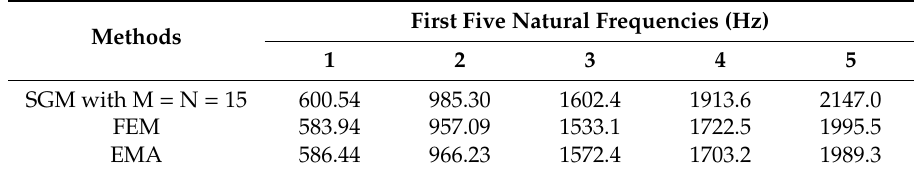
Table 3. Comparison of the first five natural frequencies for a semi-conical shell with di ff erent methods. Methods